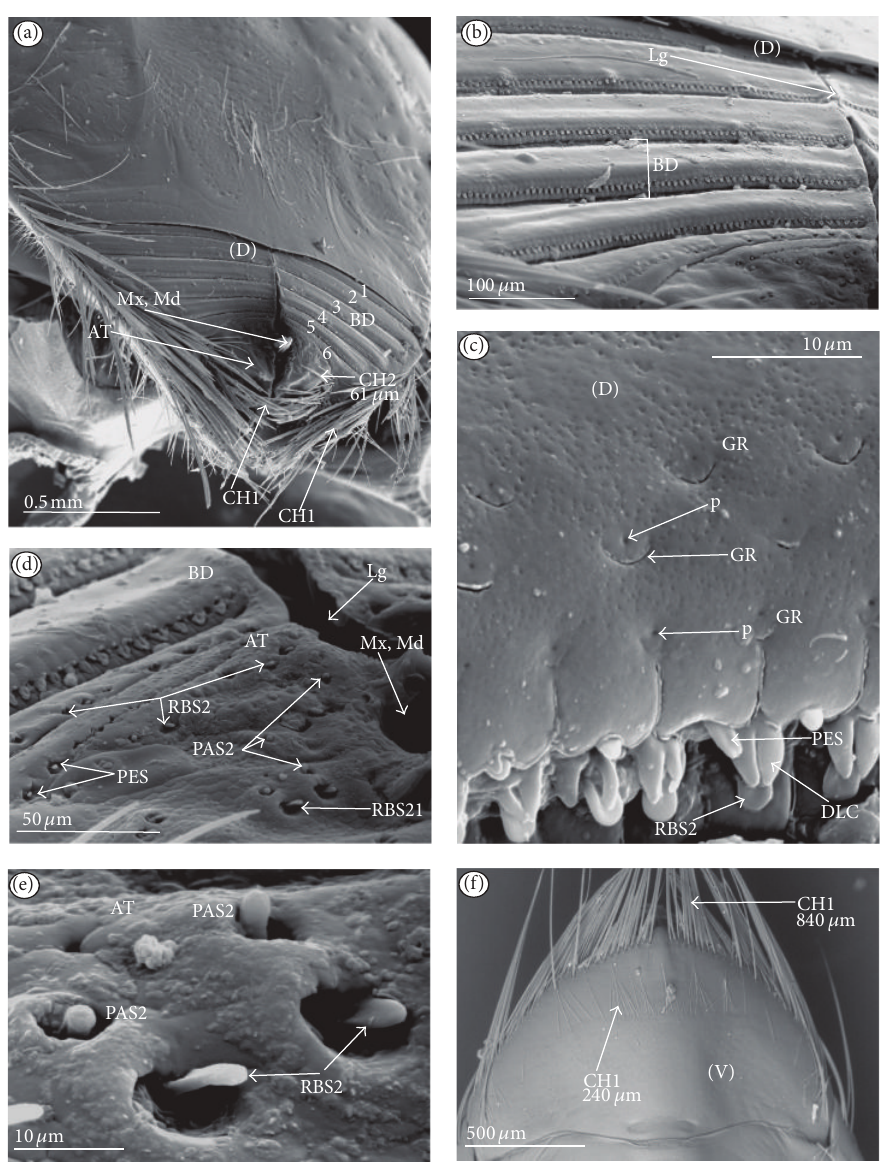
Figure 29: Types and sizes of the sensilla of the Corixidae: Corixinae ( Corixa dentipes ). (a) BD (no. 1–6) are spread evenly on the dorsal surface of the labium; several CH1 and CH2 are arranged on the lateral and ventral edges of the membranous labial lip (AT); CH1 located on the lateral edge of the labium below the apical tip. (b) BD magnified. (c) Three rows of porous sensilla (PLS) and RBS2 and RBS1 sensilla situated in two rows. (d) The apical tip (AT) with PES, PAS2, and RBS2 sensilla unevenly spread except for PES (they form a row). (e) PAS2 and RBS2 magnified. (f) Ventral view, CH1 are numerous and arranged on the lateral and frontal edges of the labium; shorter CH1 arranged in one row on the ventral side of the base of the